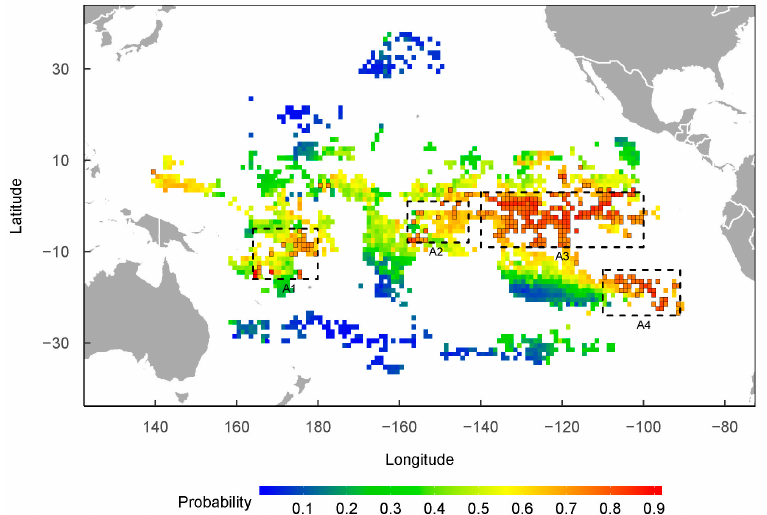
Figure 4. The spatial distribution of P. violacea ’s presence probability, predicted from the GAM model. The grids (1° × 1°) with a presence probability of ≥ 0.70 are bordered in black. The areas within the dashed border are considered the potential key habitat of P. violacea , as most of the high-probability grids are distributed in these areas.